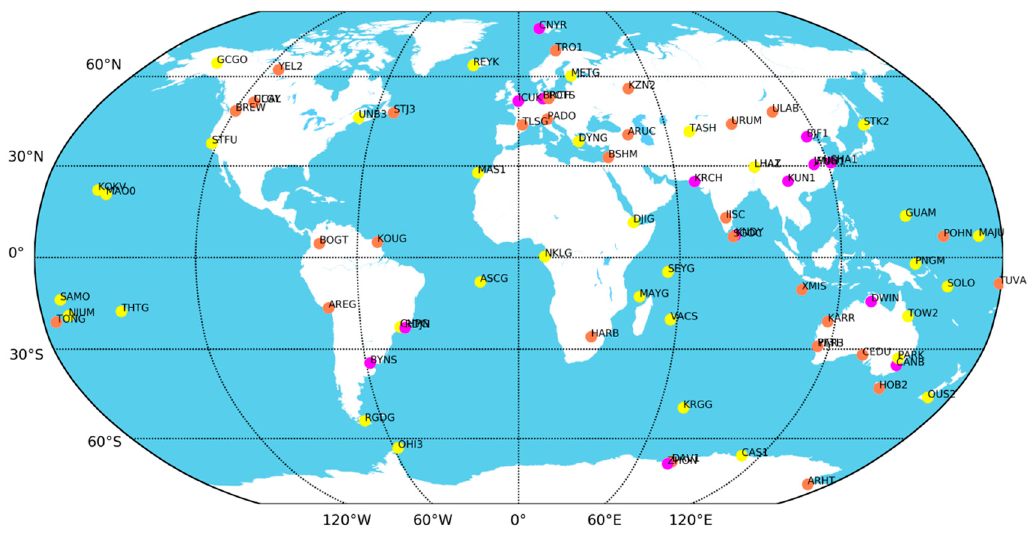
Figure 1. Distributions of precise orbit determination (POD). Magenta points are international GNSS Monitoring and Assessment System ( iGMAS) stations, which can track all BeiDou-2/3 satellites. The others are Multi-GNSS Experiment (MGEX) stations, and the orange point can track BeiDou-3 satellites. We selected one day (4 April 2019) to analyze the number of observations of BeiDou satellites.